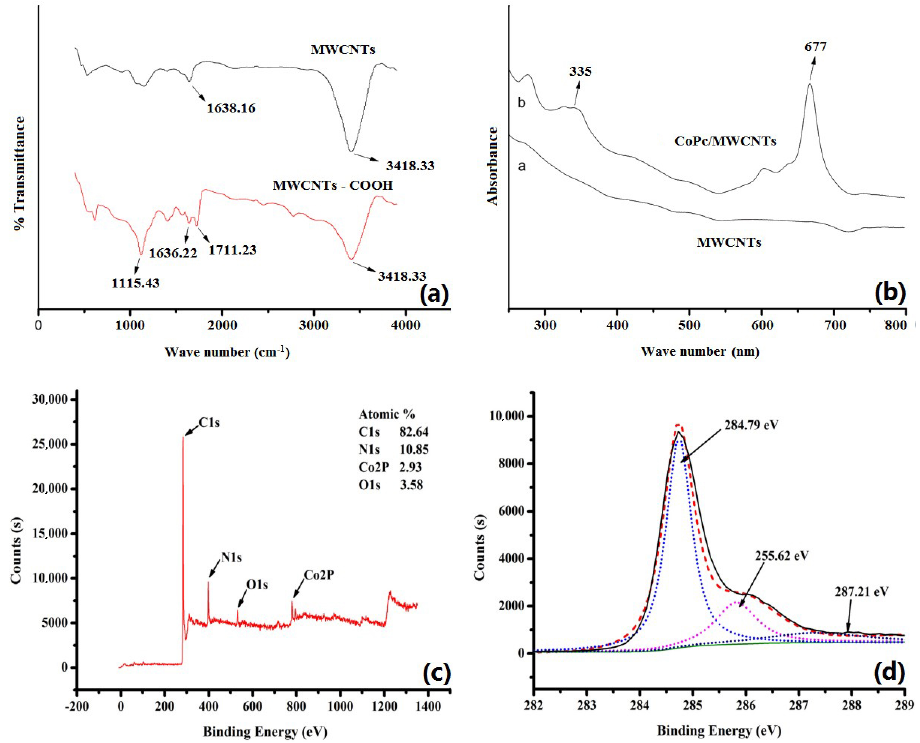
Figure 2. FTIR spectra of MWCNTs and MWCNTs-COOH ( a ), UV-vis absorption spectra of raw MWCNTs and CoPPc/MWCNTs-COOH nanocomposites ( b ); XPS spectra of CoPPc/MWCNTs- COOH ( c ), and XPS spectra of C1s ( d ).